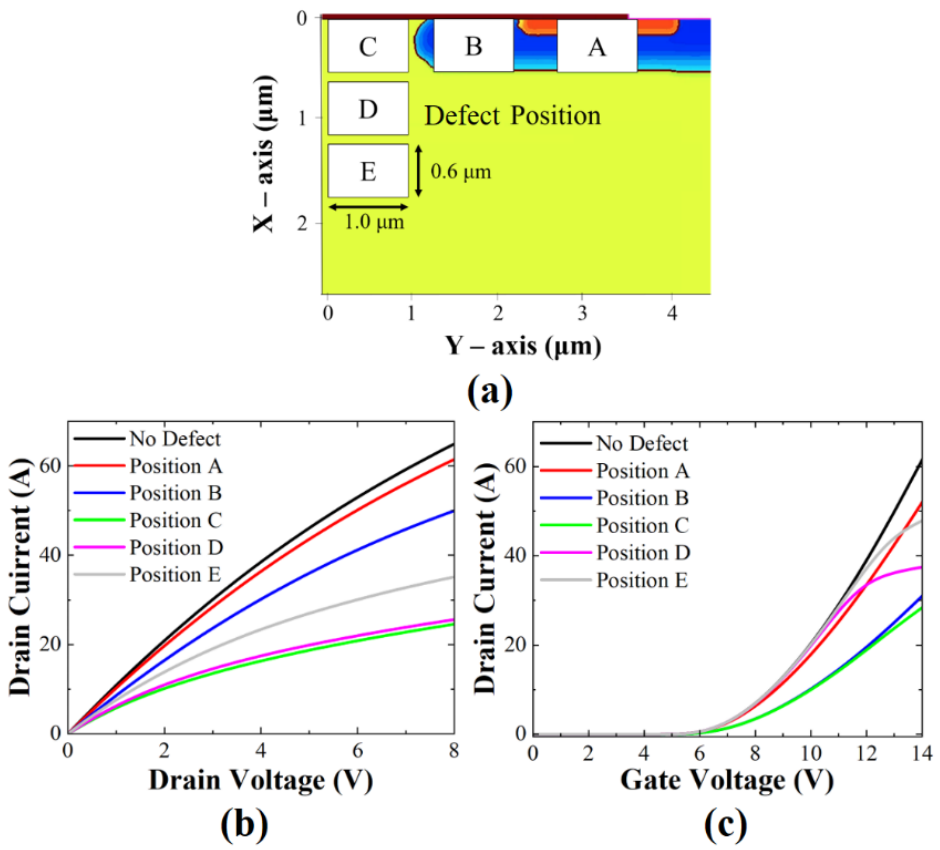
Figure 2. ( a ) Schematic of SiC MOSFET with displacement defects located at different positions. ( b ) Simulated I d –V g transfer characteristics at V DS = 20 V and ( c ) I d –V d output characteristics at V GS = 20 V with and without defect of various positions; defect energy level is fixed at E C − 1.55 eV, and defect concentration ( N d ) is 10 19 /cm 3 .